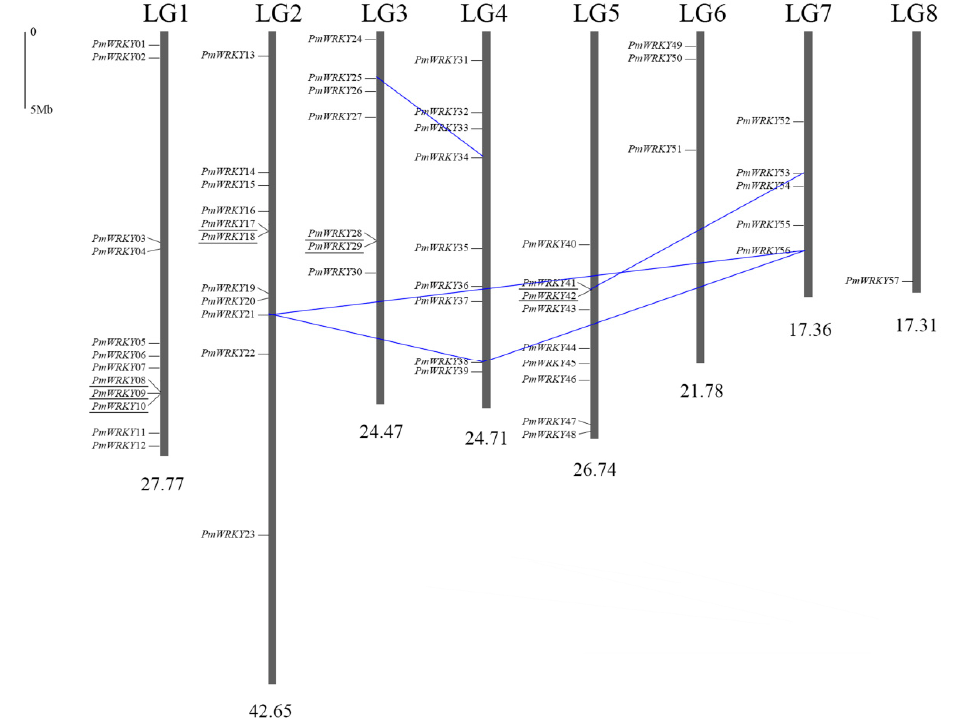
Figure 2. Localization and duplicated gene pairs of PmWRKYs . The 57 PmWRKY genes were mapped to the eight chromosomes. The chromosome number is indicated at the top. The scale refers to a 5 Mb chromosomal distance. Genes in tandem repeats are underlined in black. Segmental duplicate genes are linked by blue lines. There was a WRKY gene ( PmWRKY58 ) that could not be clearly located on the chromosomes, but could be identified on scaffolds.